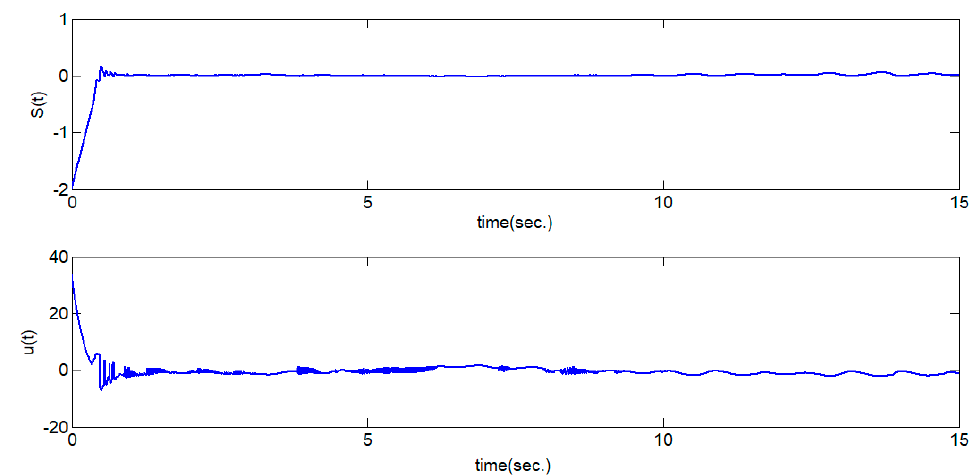
Figure 3. The time responses of the proposed SMC controller and sliding surface.